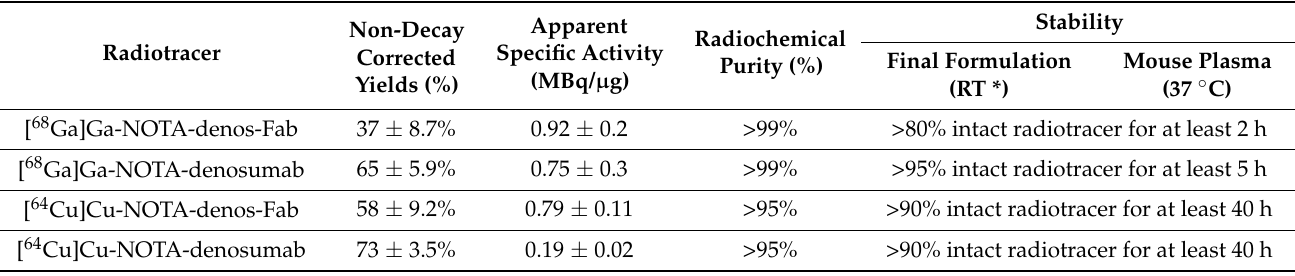
Table 2. Overview of radiolabeling of Fab fragments and